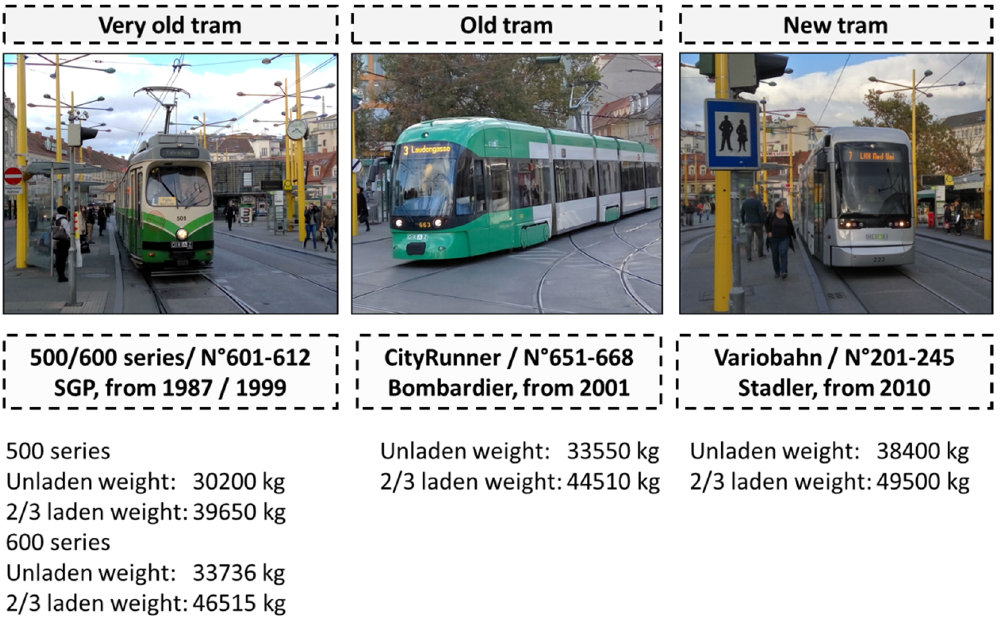
Figure 1. Tramway fleet in Graz with technical information.